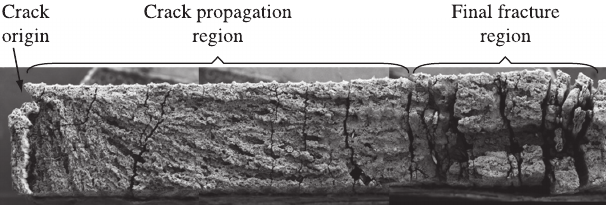
Figure 4. SEM fractograph of the tensile tested specimen. Three regions clearly distinguishing crack origin, propagation and final fracture. propagation direction and the dotted arrow indicate overall crack propagation